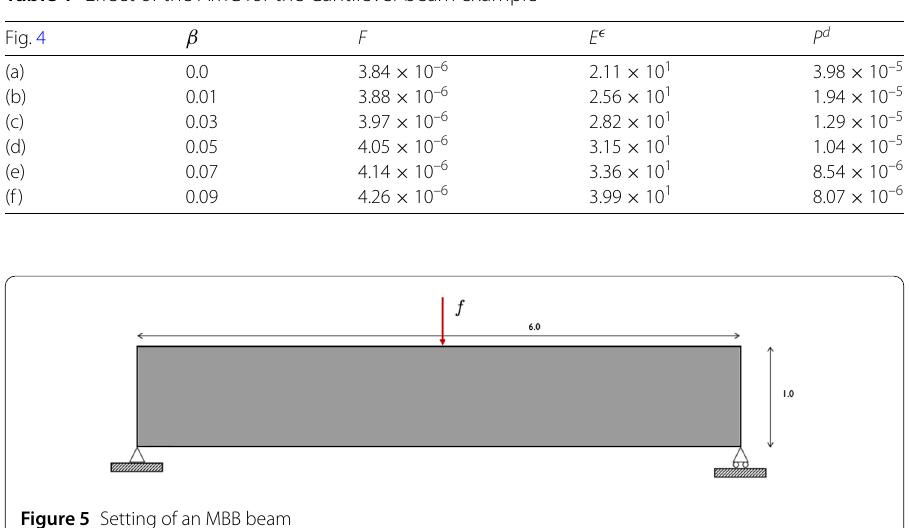
Figure 5 Setting of an MBB